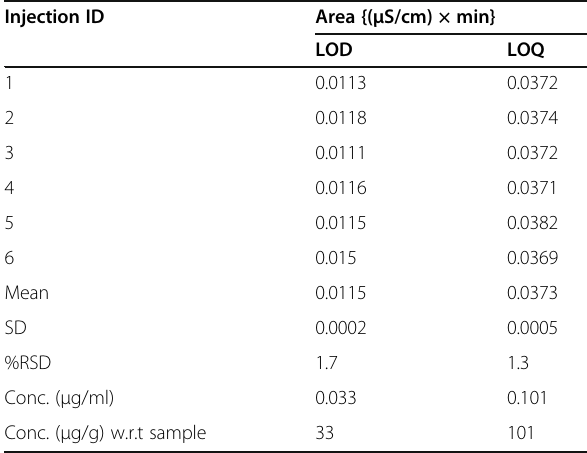
Table 3 Representation of LOD and LOQ results Injection